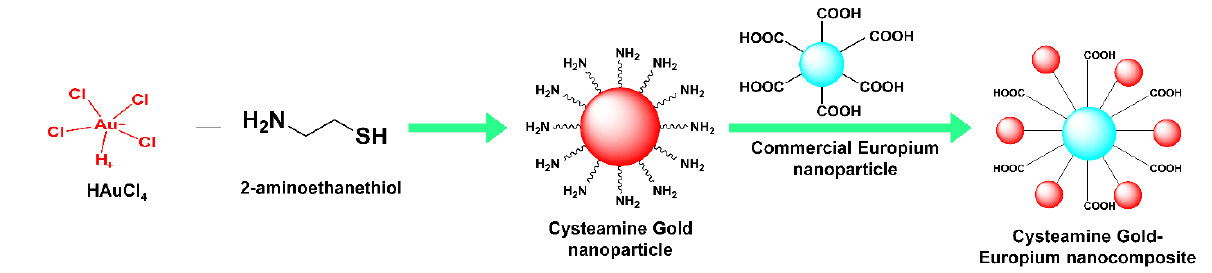
Figure 2. Schematic diagram detailing the preparation of Cys Au-Eu Nps.